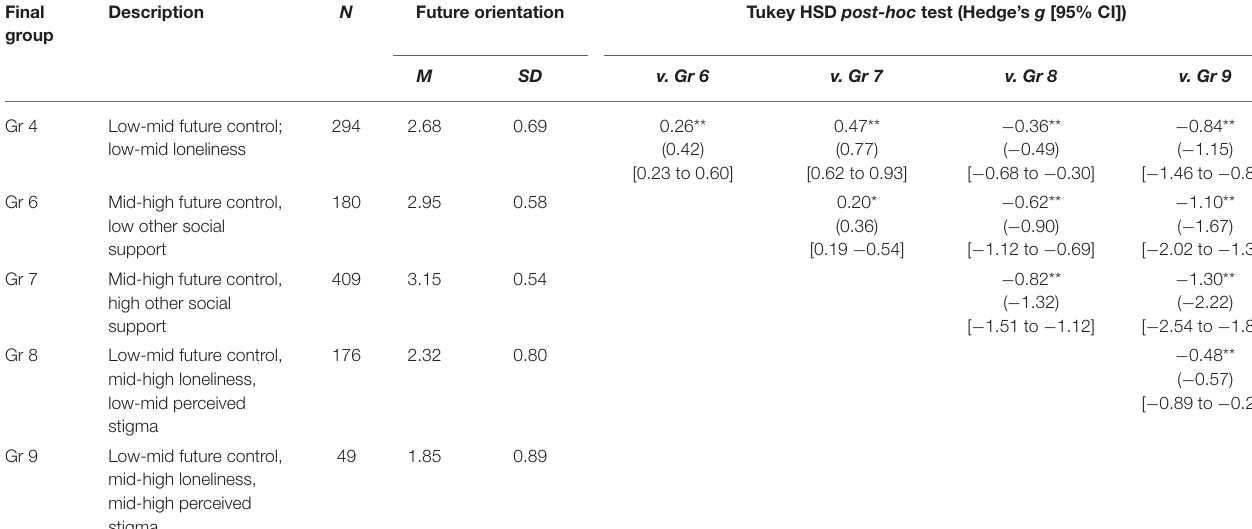
TABLE 4 | SEARCH-ing for future orientation: final search groups, descriptive statistics, and mean differences.